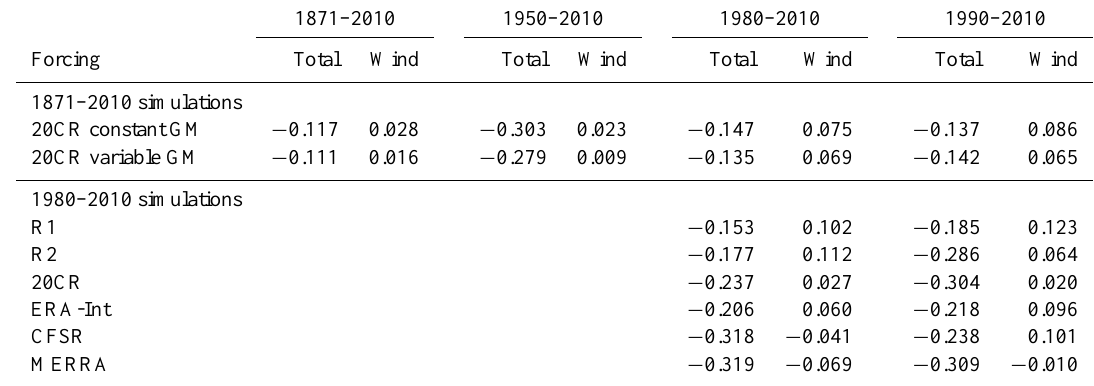
Table 2. Trends in globally integrated net surface CO 2 fluxes (Pgyr − 1 decade − 1 ). Trends that are statistically significant at the 5% level are shown in bold (based on an adjusted p value). A negative trend indicates an enhanced ocean carbon sink. Total refers to the net global surface CO 2 flux trend in the simulation. Wind refers to the surface CO 2 flux trend due to wind forcing, calculated as the trend in the transient minus fixed simulation. The 1980–2010 simulations were each done with the variable GM coefficient.